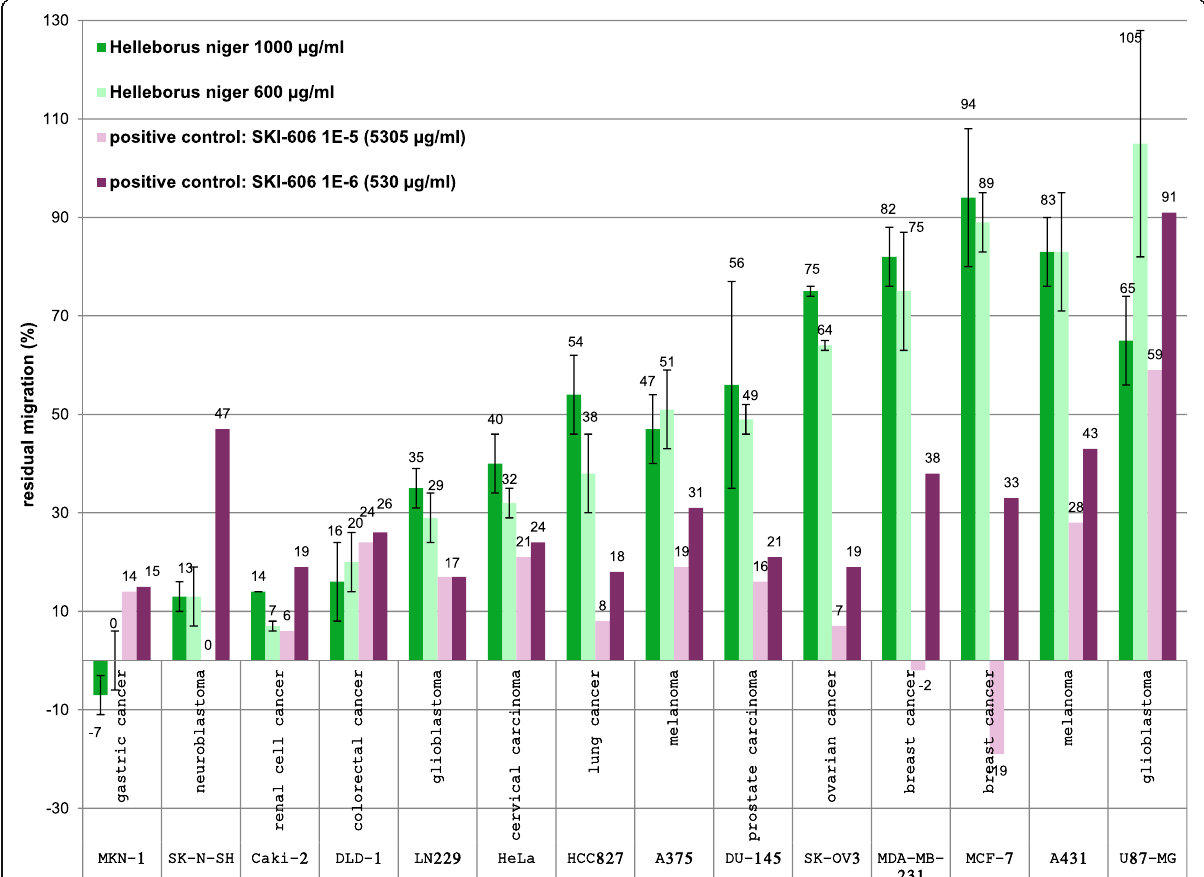
Fig. 5 Residual migration (%) of cancer cells after treatment with HNE. Residual migration (%) of 14 cancer cell lines after treatment with HNE in two different concentrations (600 and 1000 μ g/ml) compared to positive control SKI-606 in two concentrations (530 μ g/ml, 5305 μ g/ml) after 24 – 48 h depending on tumor cell lines. The cell line panel included gastric cancer (MKN-1), neuroblastoma (SK-N-SH), renal cell cancer, colorectal cancer (DLD-1), glioblastoma (LN 229 and U87-MG), cervical carcinoma (HeLa), lung cancer (HCC827), melanoma (A375 and A431), prostate carcinoma (DU-145), ovarian cancer (SK-OV3) and breast cancer (MDA-MB-231 and MCF-7). Value ranges over 100% do not mean a support of tumor cell migration but are rather due to artifact interactions in the